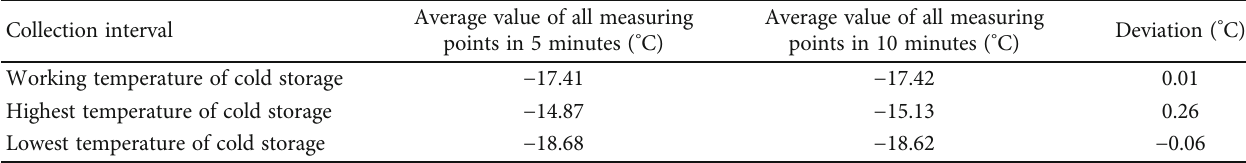
Table 2: Comparison of the results of di ff erent acquisition time intervals at all temperature measurement points in the cold storage.